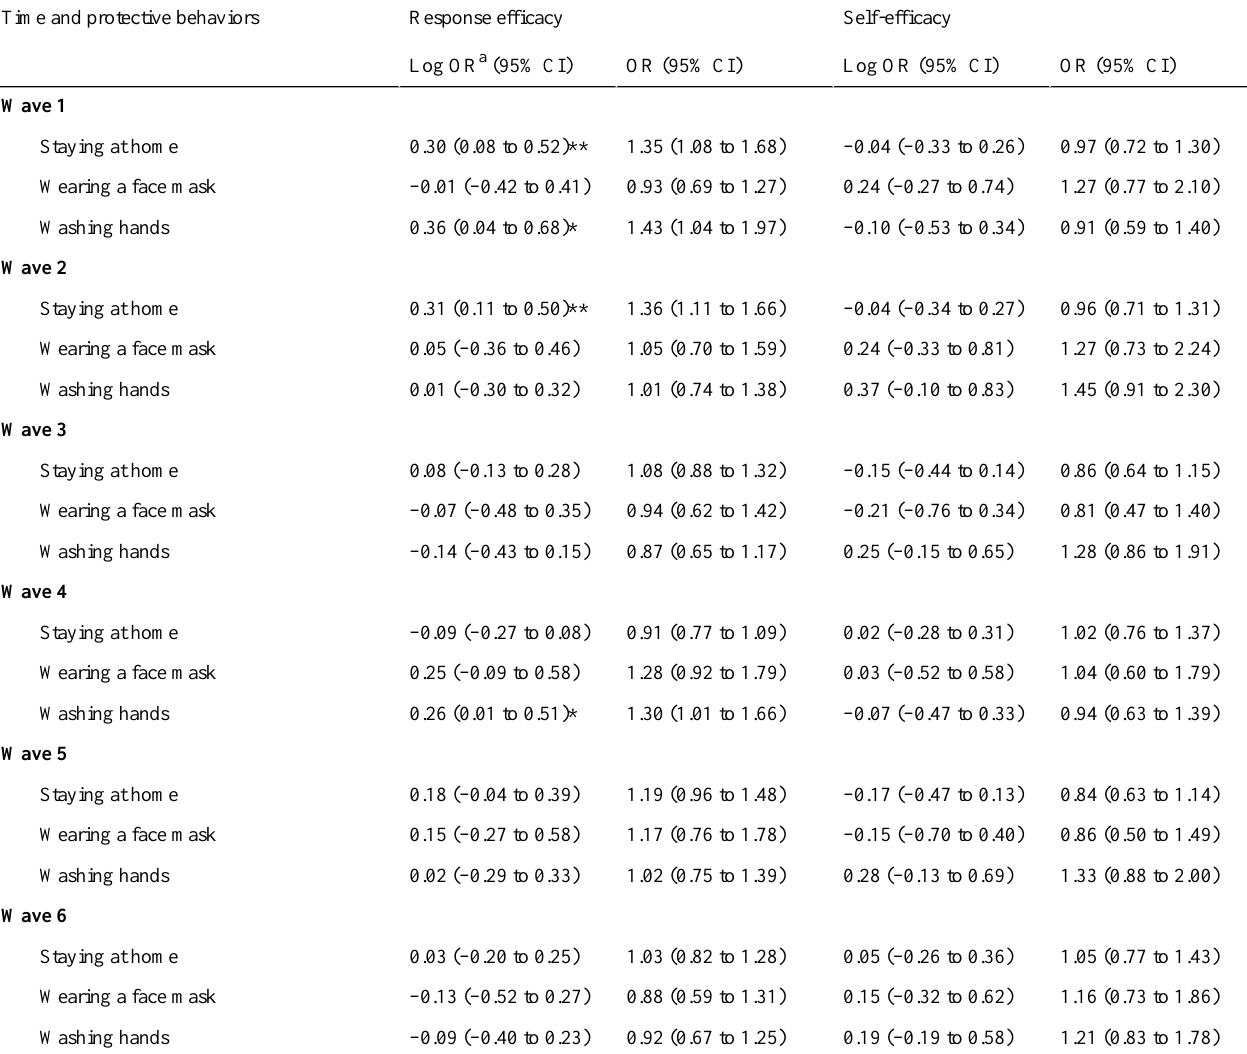
Table 5. The effects of response efficacy and self-efficacy on engagement in protective behaviors across time.